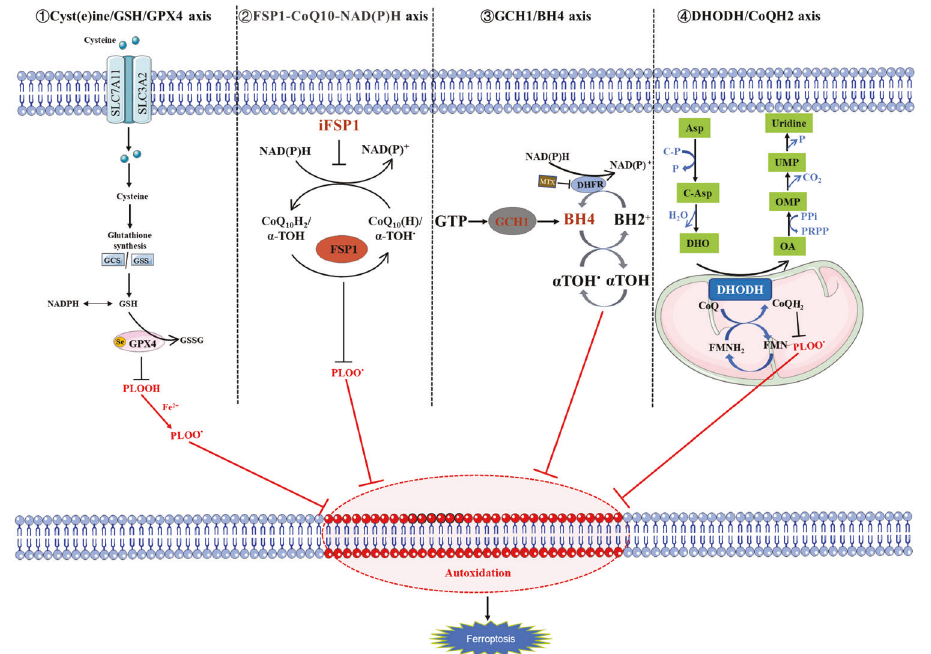
Fig. 1 Four ferroptosis defense pathways. Four ferroptosis defense pathways have been found so far, namely, Cyst(e)ine/GSH/GPX4 axis, FSP1-CoQ10-NAD(P)H axis, GCH1/BH4 axis, and DHODH/CoQH2 axis; ① GPX4 speci fi cally catalyzes the loss of oxidative activity of lipid peroxides through glutathione (GSH)-dependent manner, and protects cells from the threat of ferroptosis is the most classic way; ② as a phospholipid peroxidation inhibitor that does not rely on glutathione, FSP1 converts ubiquinone on the cell membrane into reduced ubiquinol, which can inhibit peroxidation and prevent ferroptosis; ③ the GCH1/BH4 pathway acts as an endogenous antioxidant pathway, GCH1 protects cells from ferroptosis primarily through the antioxidant action of BH4; ④ DHODH resists ferroptosis in mitochondria by regulating the production of dihydroubiquinone in the inner membrane of